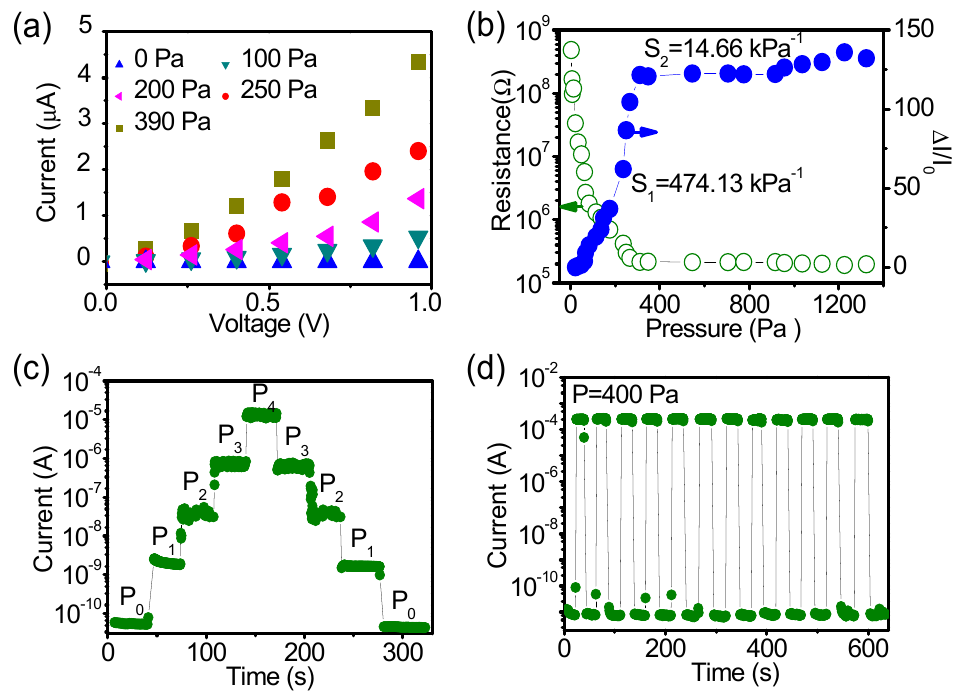
Figure 3. Sensitivity and repeatability of the sensor with large area of Au film (4.4 × 10 − 5 m 2 ). ( a ) Current-voltage curves of the device under different amount of pressure loading; ( b ) The dependency of sensitivity and total resistance on pressure under the same pressure range (0 to 1400 Pa); ( c ) Current response of the sensor under step pressure and certain applied voltage of 5 V, P 0 = 0 Pa, P 1 = 11 Pa, P 2 = 25 Pa, P 3 = 52 Pa and P 4 = 118 Pa; ( d ) Cycle test of sensor under pressure of 400 Pa and voltage of 1 V.